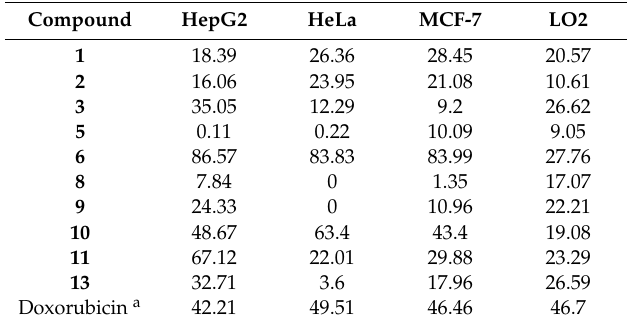
Table 2. Cytotoxicity (%I @ 4 mg / mL)) of compounds from Juniperus oblonga against various cell lines. Compound